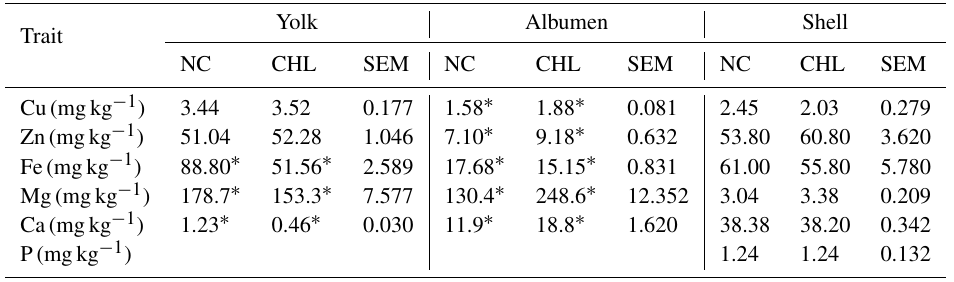
Table 3. The content of mineral elements in each egg element depending on the group. Yolk Albumen Shell Trait NC CHL SEM NC CHL